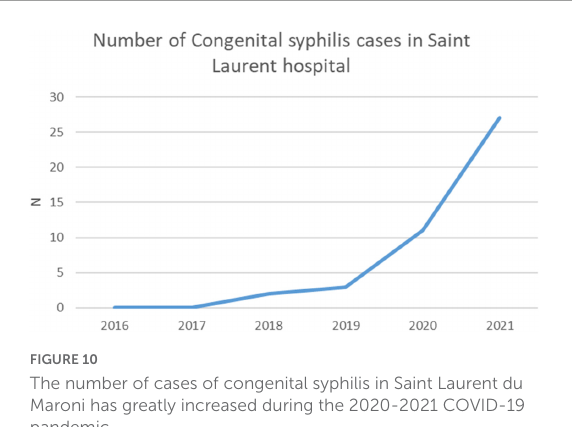
FIGURE9 The evolution of the number of HBV tests in the health centers on the French side of the Maroni river show a general increase over time. The disruptions due to COVID-19 have however had an impact in Maripasoula and Papaïchton.